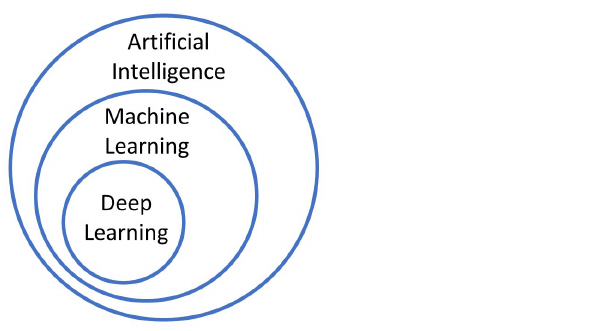
Figure 5. Hierarchy of artificial intelligence, machine learning, and deep learning.